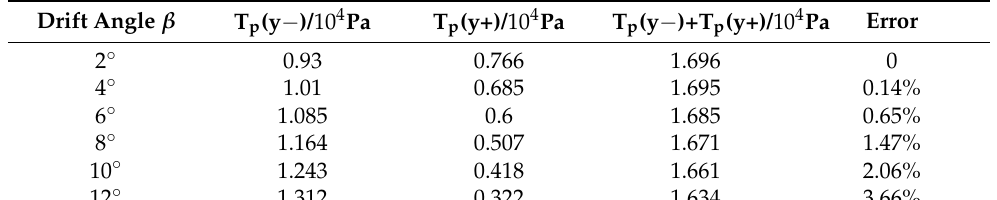
Table 5. Pressure gauge at the red mark.